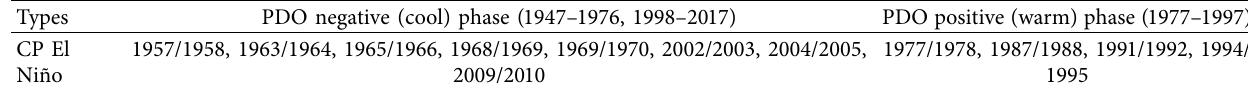
Table 1: List of CP El Niño years classified based on the different PDO phases during